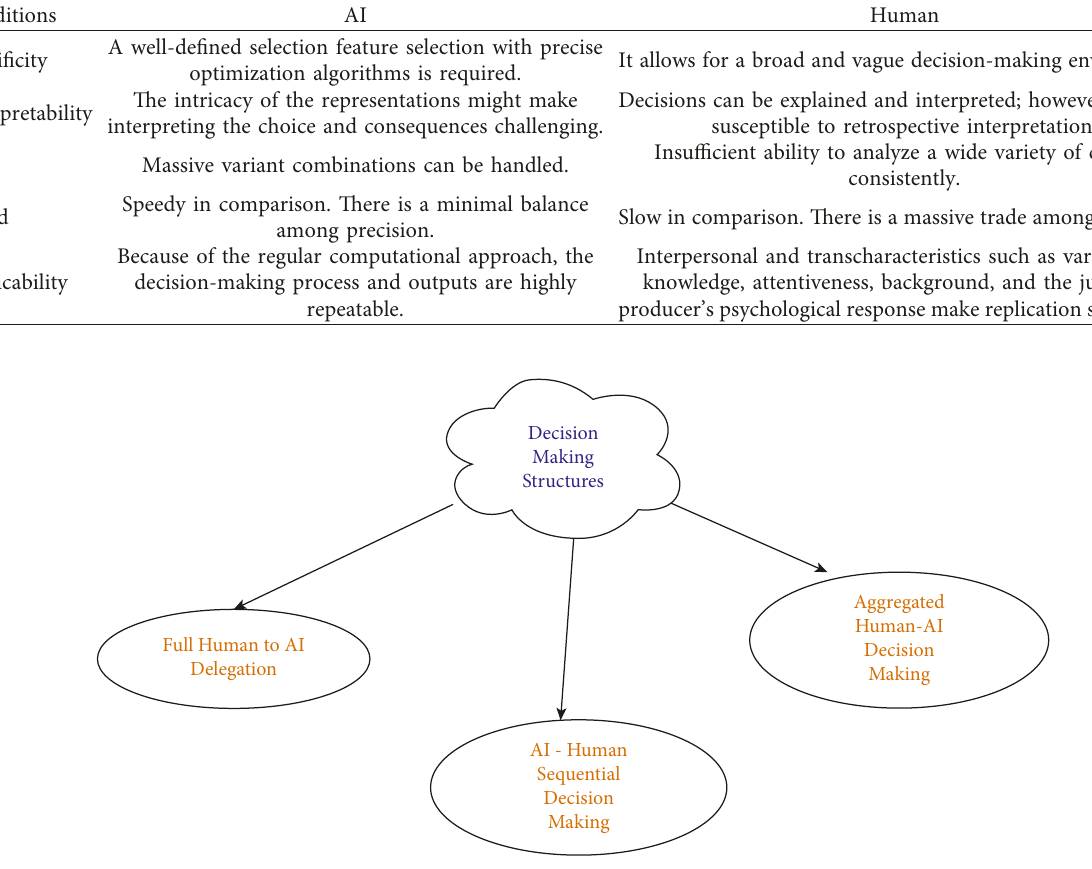
Figure 5: Conceptual framework. Table 2: Personnel versus AI-policymaking process.